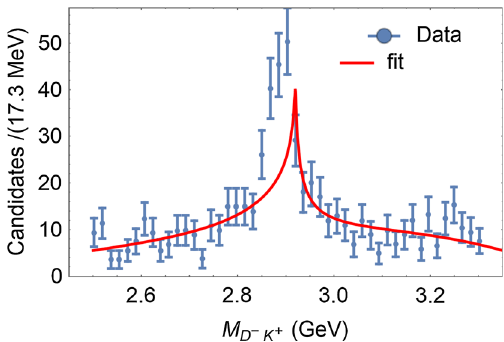
Fig. 5 Fit result of a single triangle diagram. Data are from Ref.